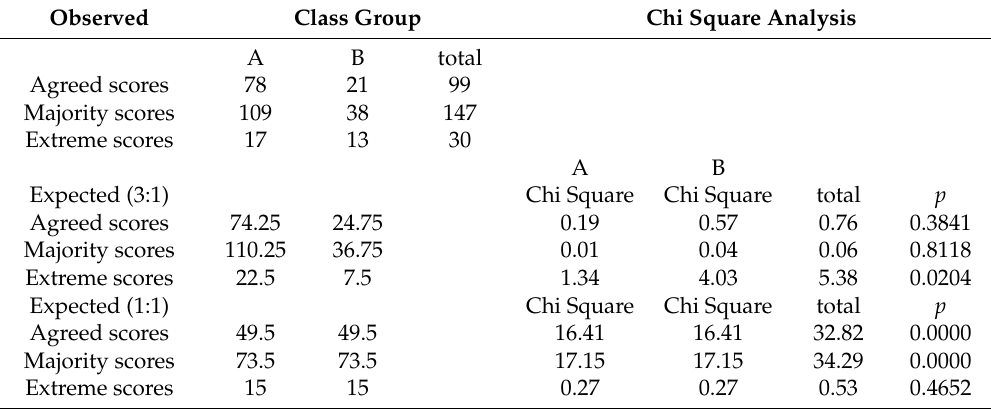
Table 3. Analysis of seed phenotype segregation in JI 281 × JI 2110 RILs (F9, F10 and F11), with chi square and probability values for a goodness of fit to 3:1 and 1:1 segregation ratios. Scores are classified according to their agreement across three generations (F9, F10 and F11) for round-seeded (A class) or wrinkled-seeded (B class) phenotype. Chi Square